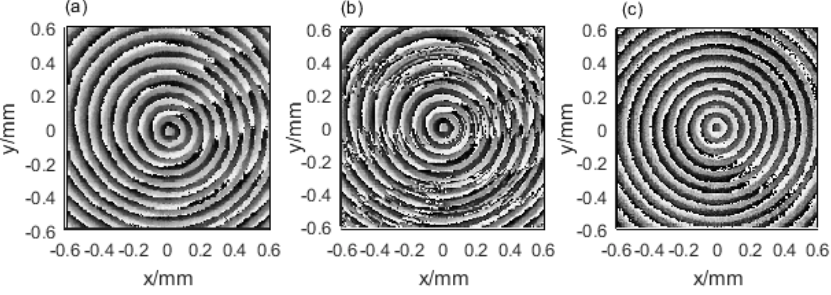
Figure 3. solved phase with different phase-shifted holograms. ( a ) Four phase-shifted holograms; ( b ) five phase-shifted holograms; ( c ) eight phase-shifted holograms.